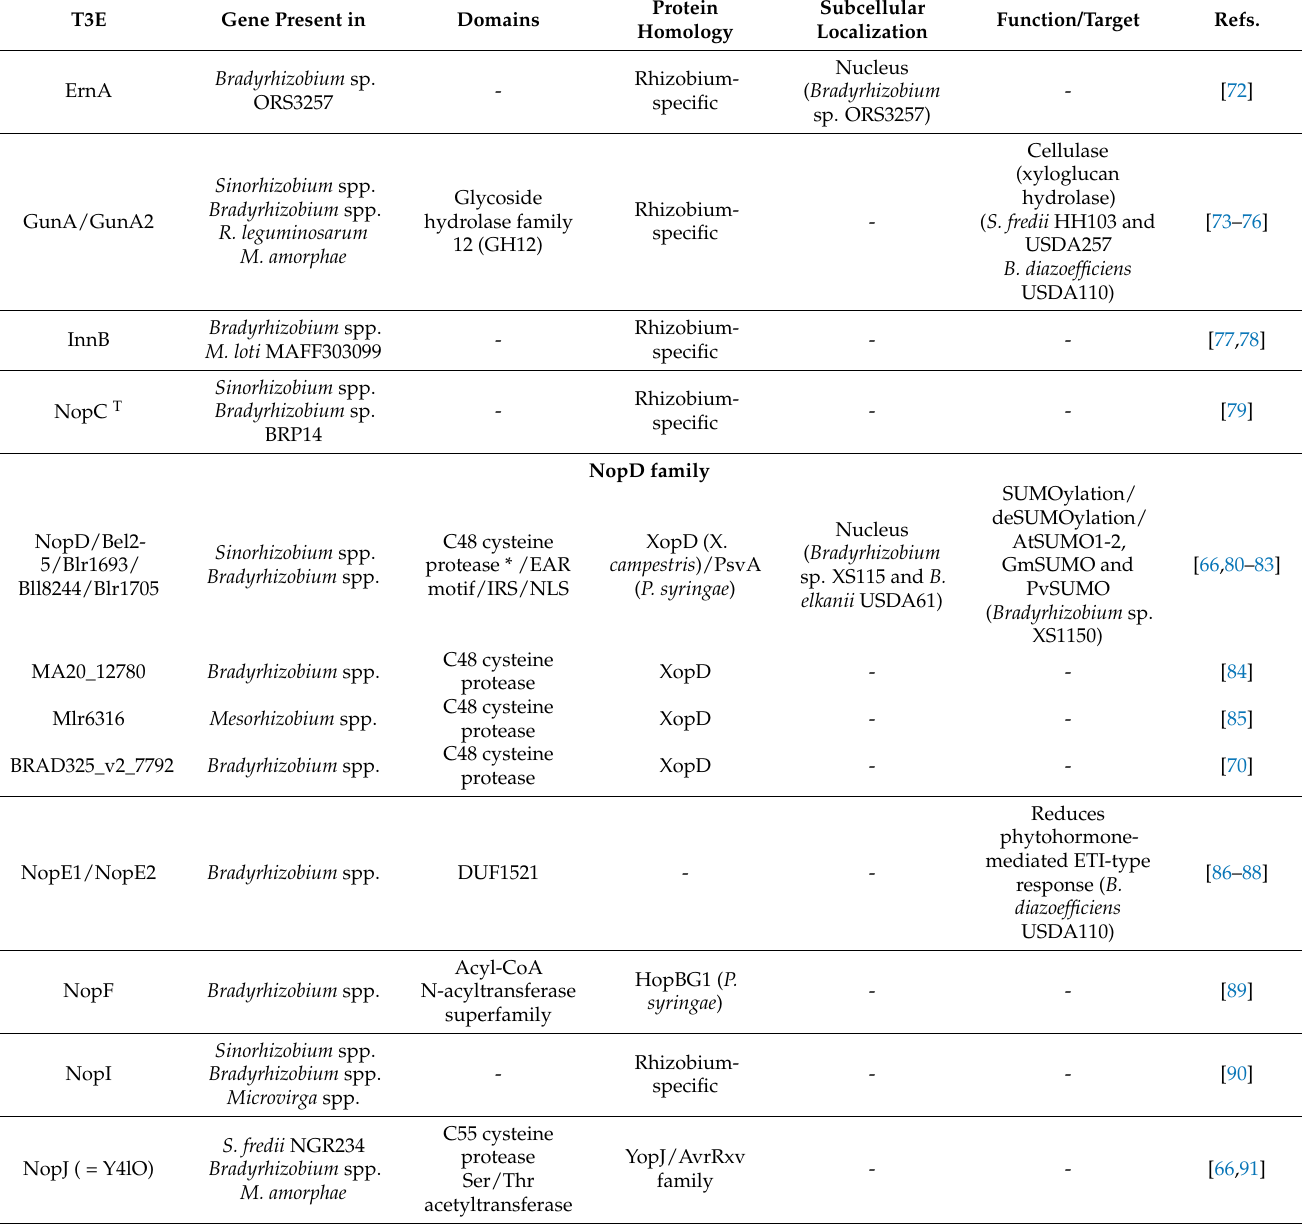
Table 1. List of described rhizobial type three secretion system